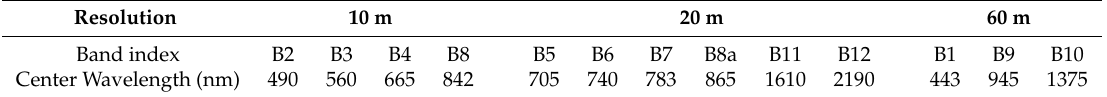
Table 1. The corresponding bands for Sentinel-2